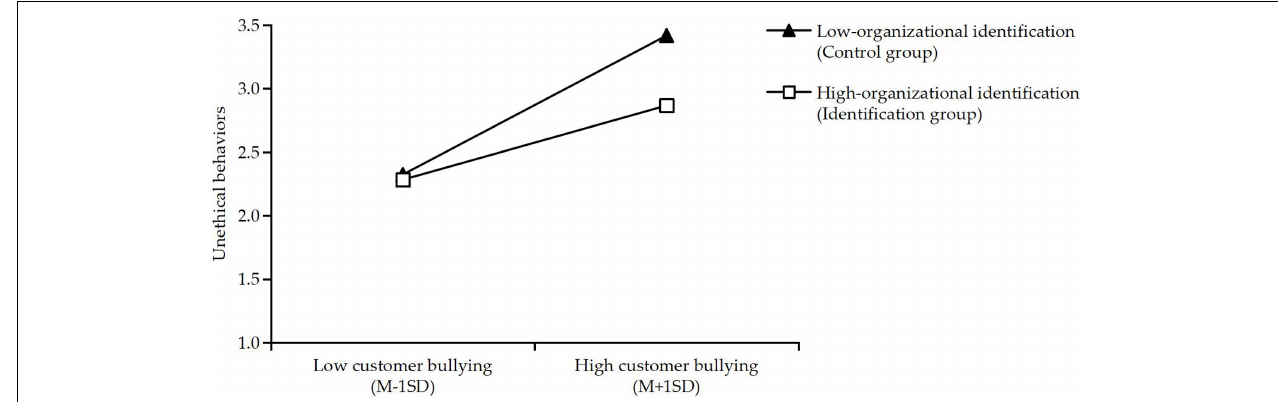
FIGURE 2 | Showing the interactive effects of customer bullying and organizational identification on unethical behaviors. Slope for low organizational identification ( β = 0.81, p < 0.001); slope for high organizational identification ( β = 0.66, p < 0.01). Low-organizational identification, control group; high-organizational identification, identification group. Low customer bullying, M - 1 SD (one standard deviation below the mean). High customer bullying, M + 1 SD (one standard deviation above the mean).